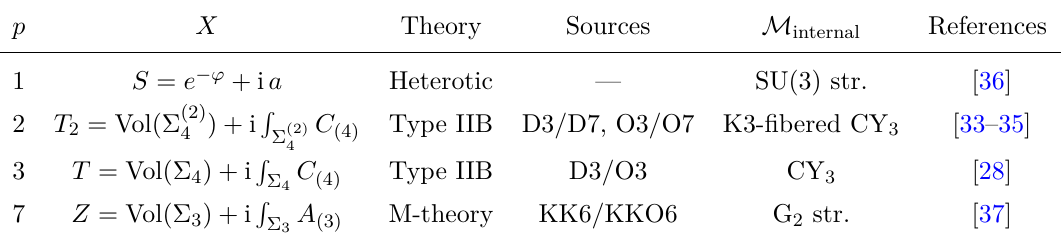
Table 2 . Examples of string compactifications yielding 4D two-field models with exponential kinetic coupling and exponential runaway potential. The two-field models arise after fixing the rest of the moduli present in the given